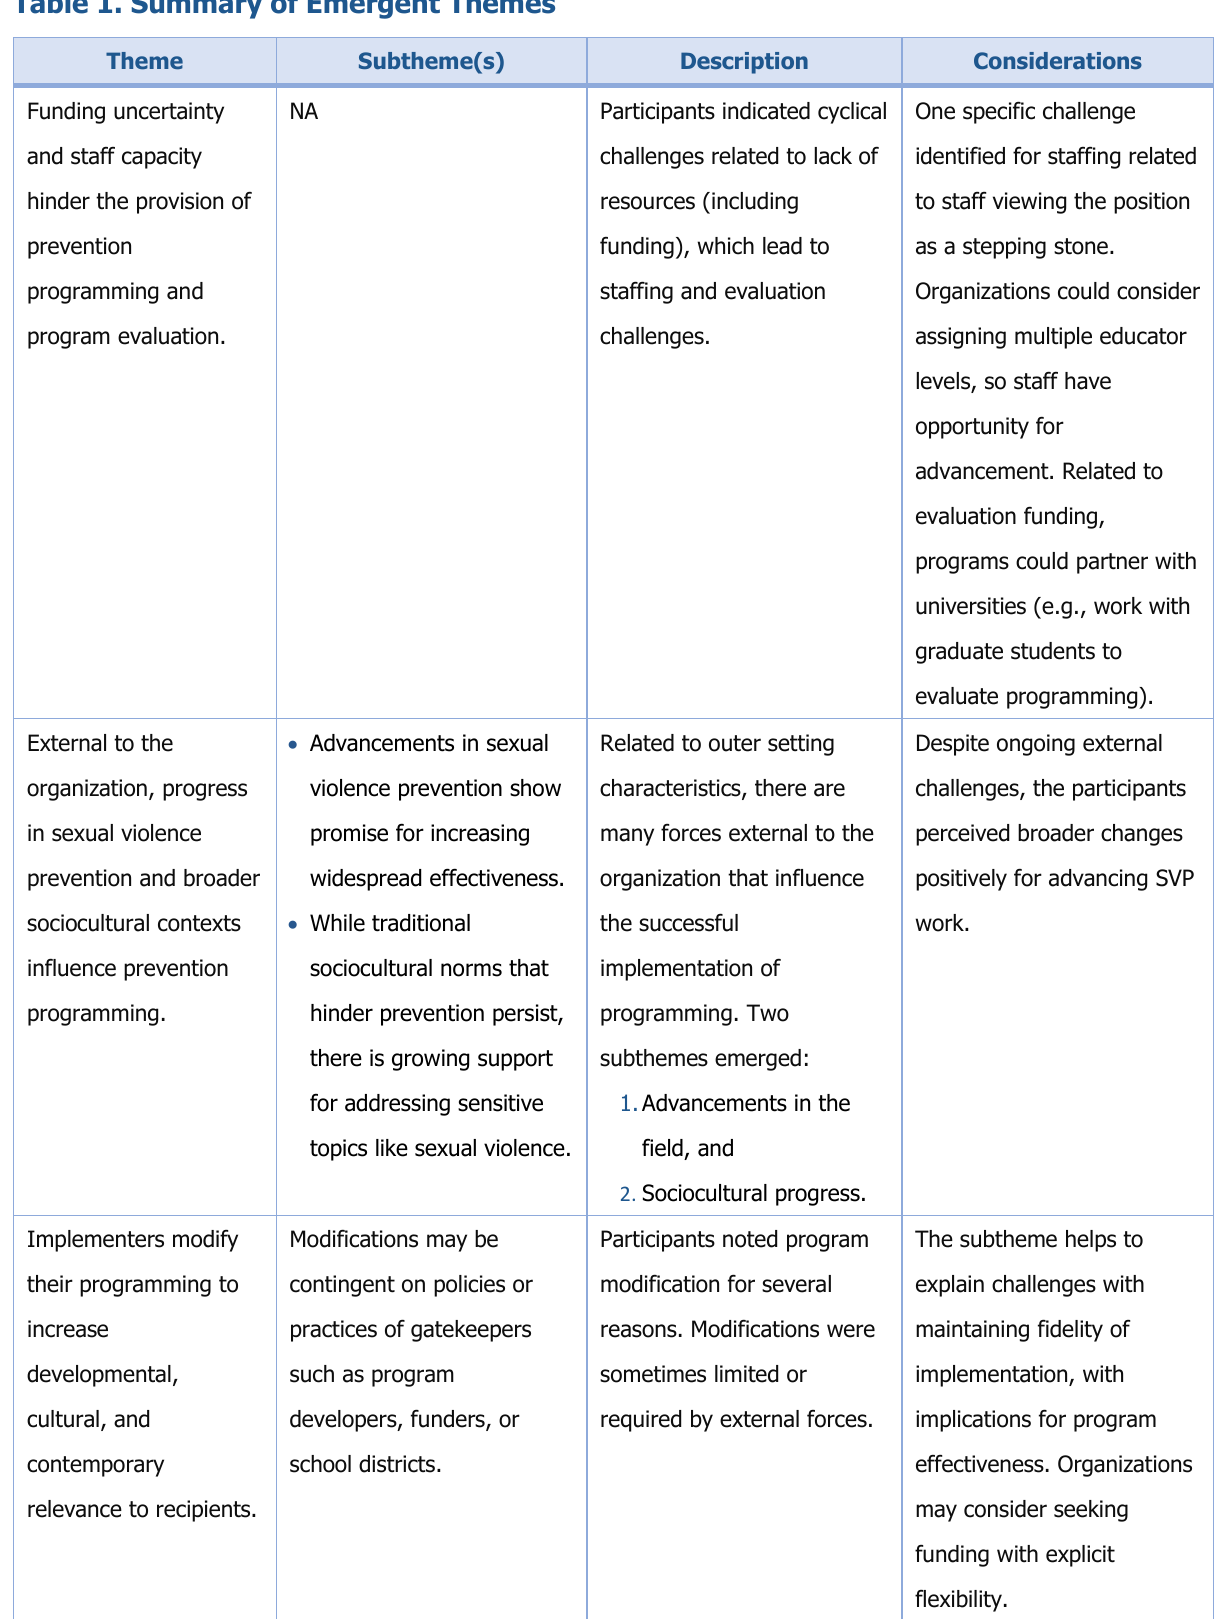
Table 1. Summary of Emergent